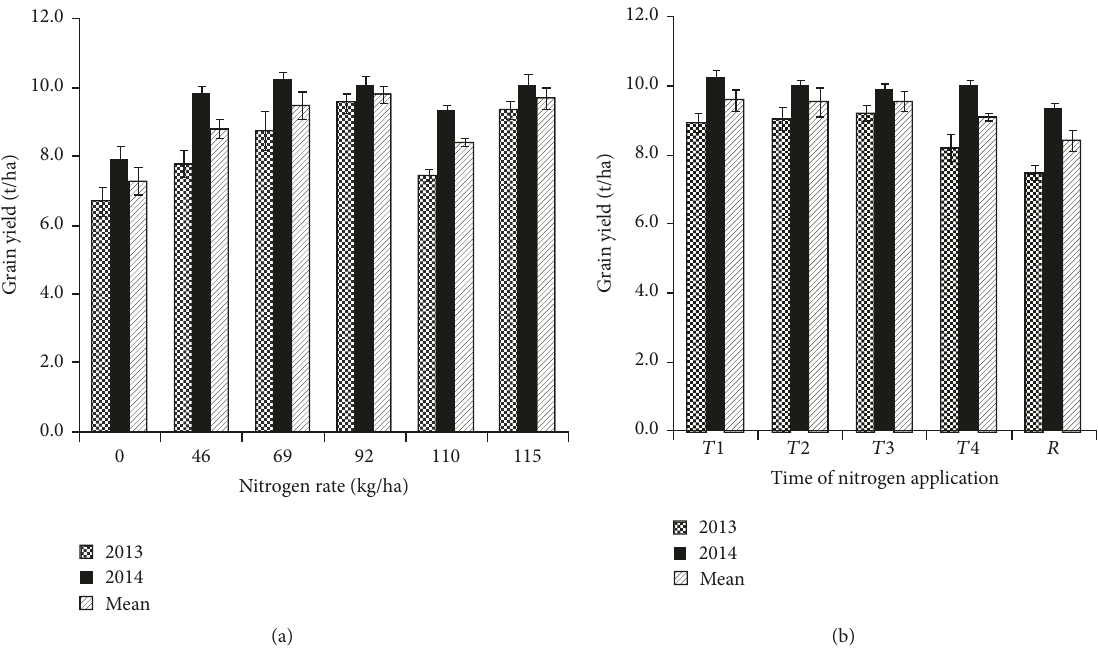
Figure 2: The effect of nitrogen rates (a) and application time (b) on the yield of maize in the 2013 and 2014 cropping seasons at Bako, Western